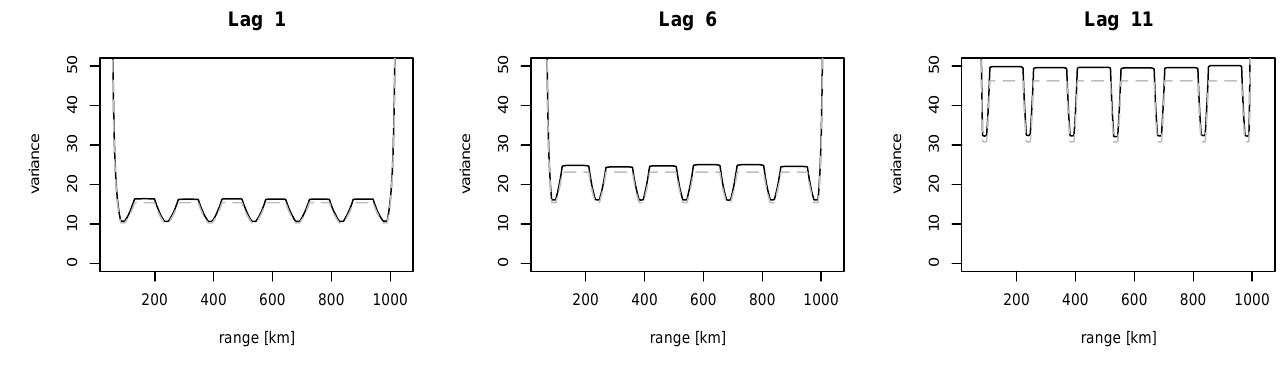
Fig. 4. Normalised variances of selected lags of the PPATC experiment with 48 phase-coded pulses and 3 different IPPs. The continuous black line is the actual posteriori variance of the lag profile and the grey dashed line is the smallest possible variance with the given IPPs and pulse